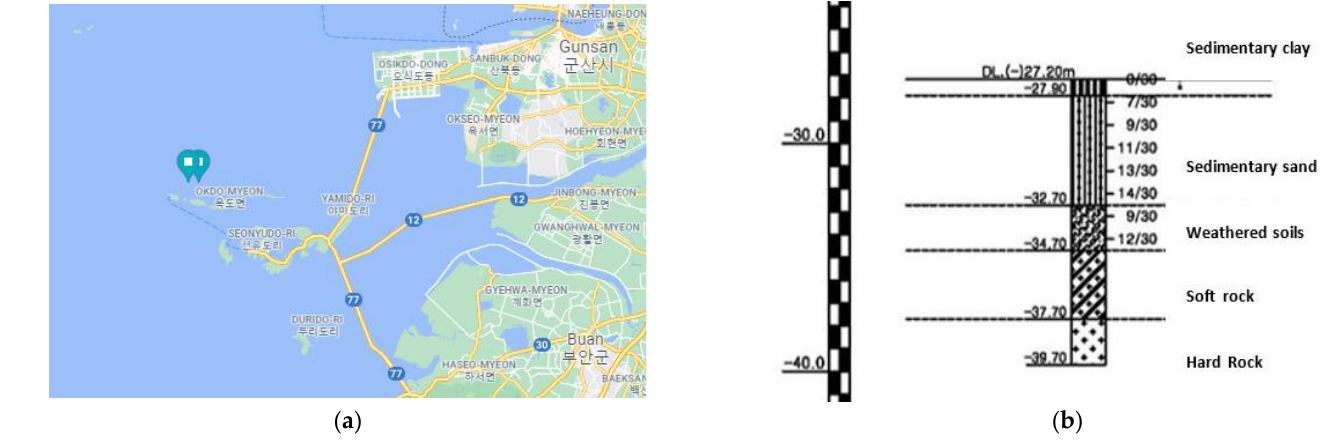
Figure 1. Installation area: ( a ) map; ( b ) soil layer. Table 1. Soil profile of survey site.